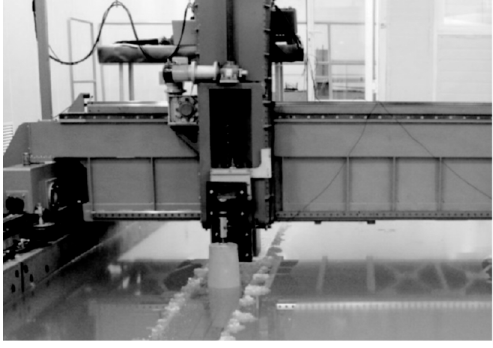
Figure 13. Sketch of the tested structures in full scale.